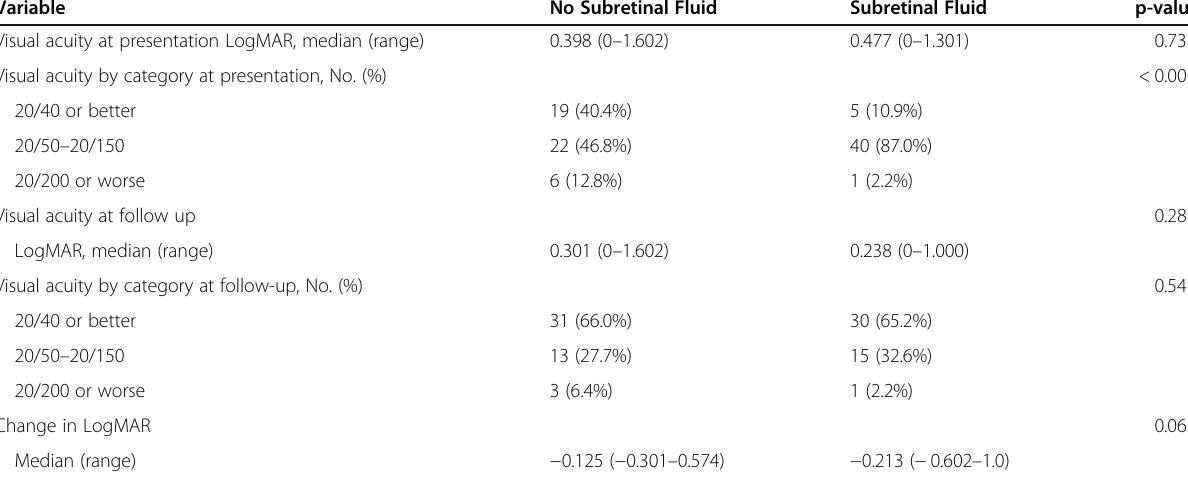
Table 2 Visual acuity in Eyes with Uveitic Cystoid Macular Edema, Comparing eyes with and without Subretinal Fluid. N = 93 Variable No Subretinal Fluid Subretinal Fluid p-value Visual acuity at presentation LogMAR, median